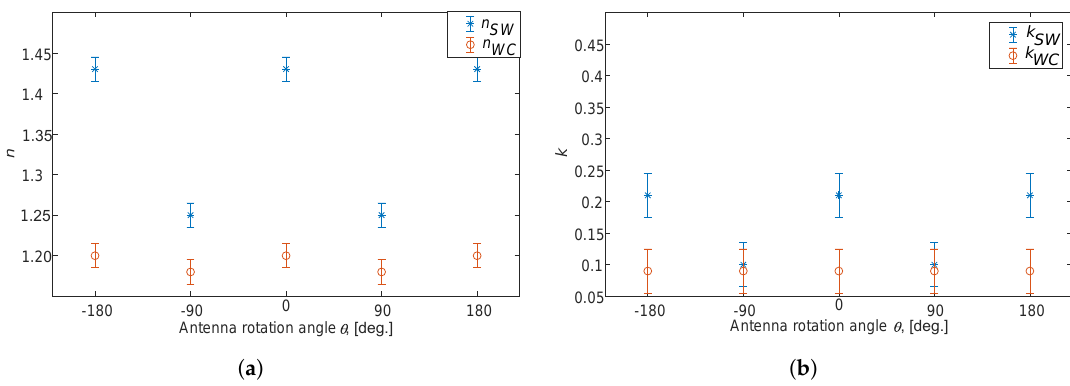
Figure 9. The refractive index of dry SW and dry WCs for different antenna rotation angles, ( a ) real part, n , and ( b ) imaginary part, k . Notice that θ = 0 ◦ , ± 180 ◦ corresponds to (cid:107)(cid:107) and θ = ± 90 ◦ corresponds to ⊥⊥ .